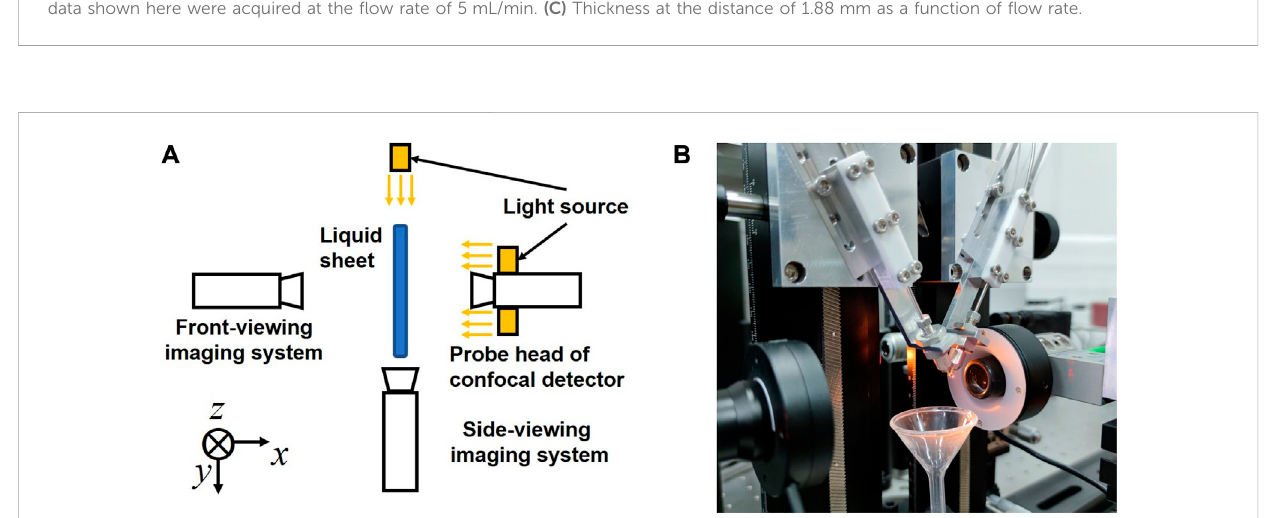
FIGURE 3 (A) Schematic and (B) photograph of the measurement setup. The confocal detector is used to measure the motion of the sheets. Two imaging systems record the experimental parameters. Multiple light sources are used for imaging illumination.